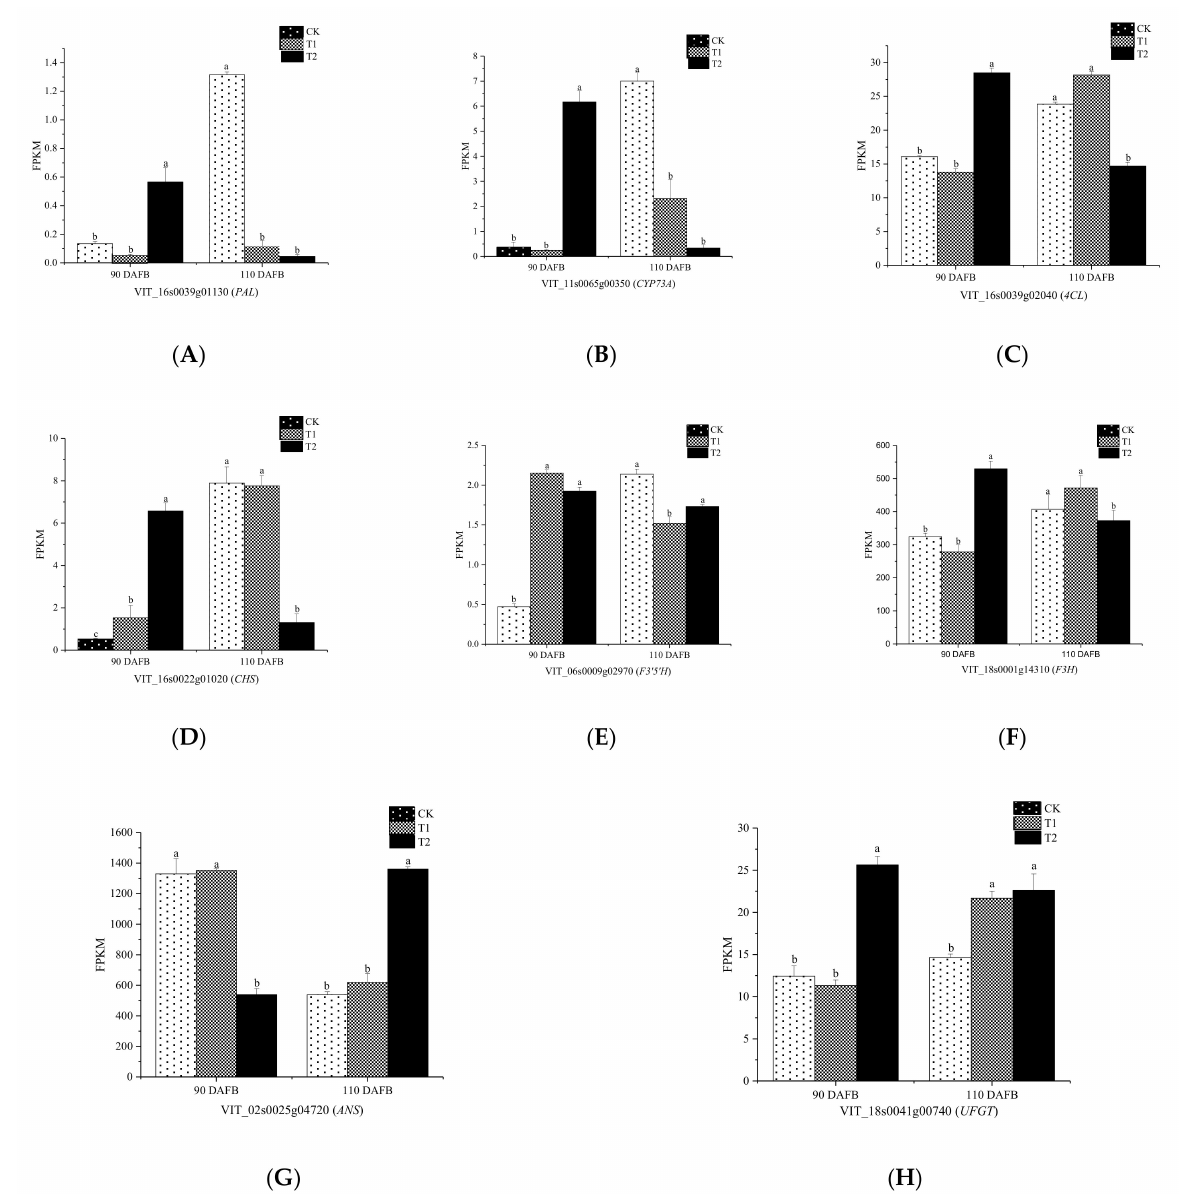
Figure 5. The expression analysis of key genes for flavonoid biosynthesis in grape berries under different potassium fertilizer treatments at two stages. Expression of the PAL ( A ), CYP73A ( B ), 4CL ( C ), CHS ( D ), F3 (cid:48) 5 (cid:48) H ( E ), F3H ( F ), ANS ( G